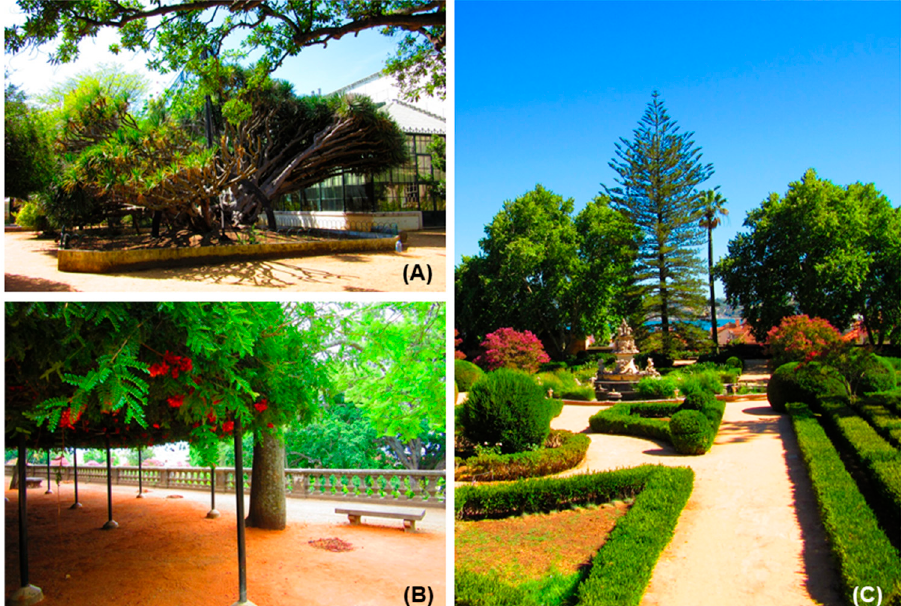
Figure 6. The iconic specimens of JBA: ( A ) Dracaena draco, probably one of the oldest specimens in the garden; ( B ) Schotia afra, the only living specimen in a European botanical garden; ( C ) Garden perspective showing the specimen of Araucaria heterophylla in the background (Photos: Cunha).